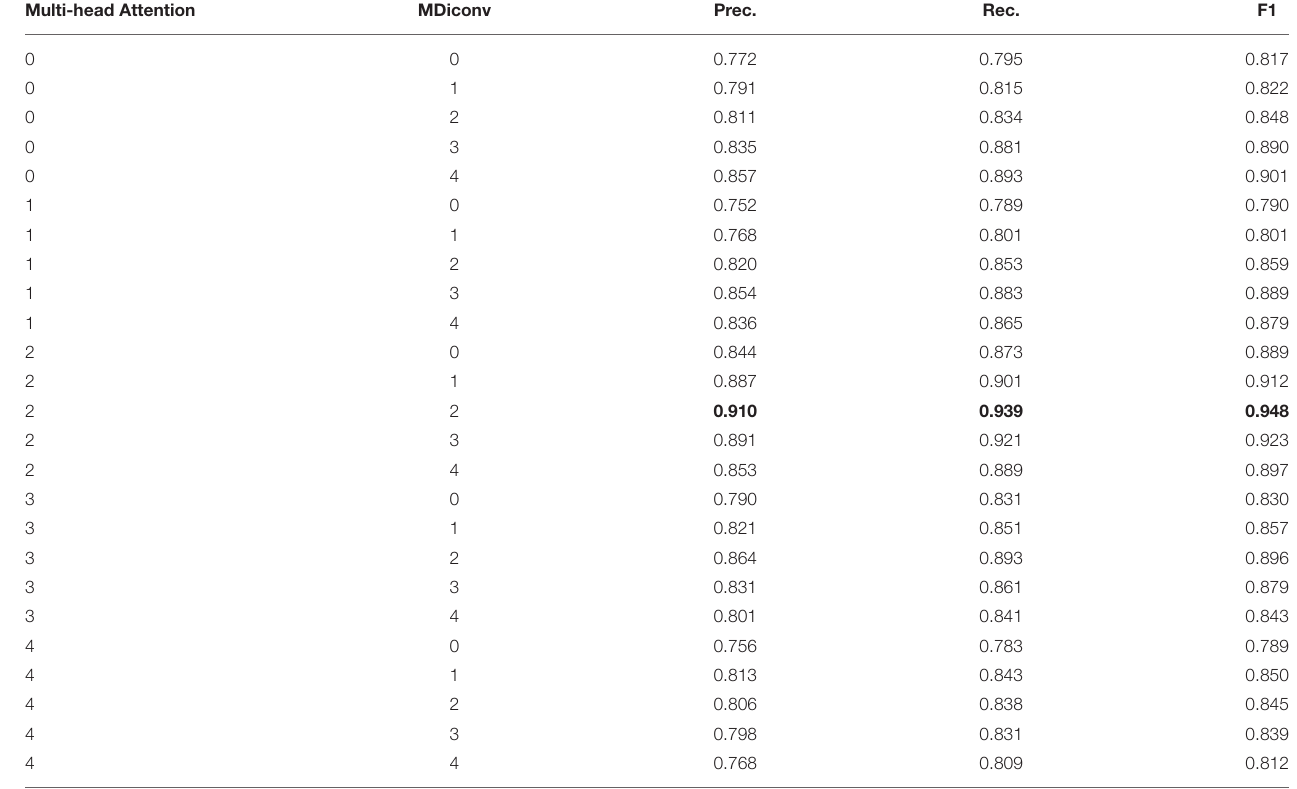
TABLE 5 | Ablation experiments for CWRL with different combinations. Multi-head Attention MDiconv Prec. Rec. F1